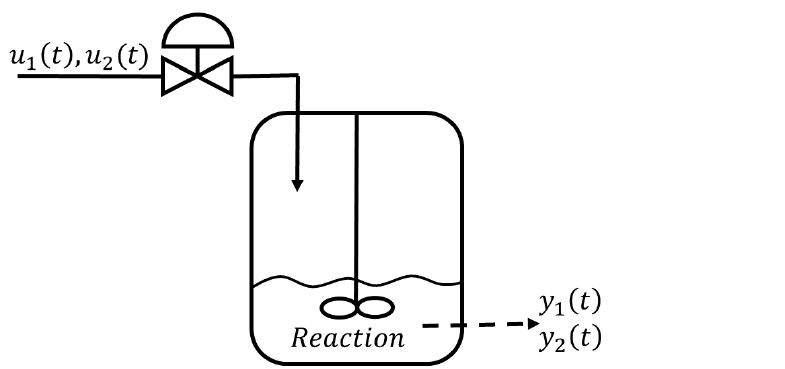
Figure 8. Scheme of the yeast